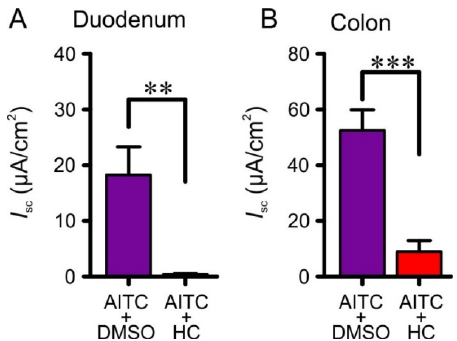
Figure 4. The TRPA1 receptor antagonist, HC ‐ 030031 (HC; 100 μ M), reduced the effects of AITC (100 μ M) in both the duodenum ( A ) and colon ( B ). *** p < 0.01; ** p < 0.05. DMSO is the vehicle for dissolving HC ‐ 030031.